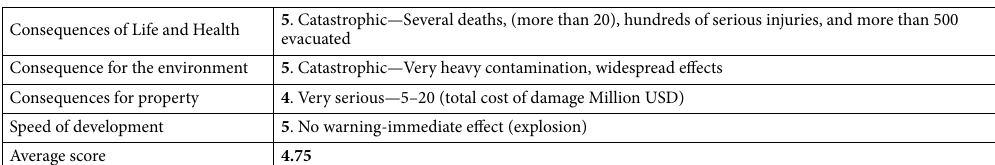
Table 3. Score assigned to each consequence indicator if the chemical facilities cluster is being